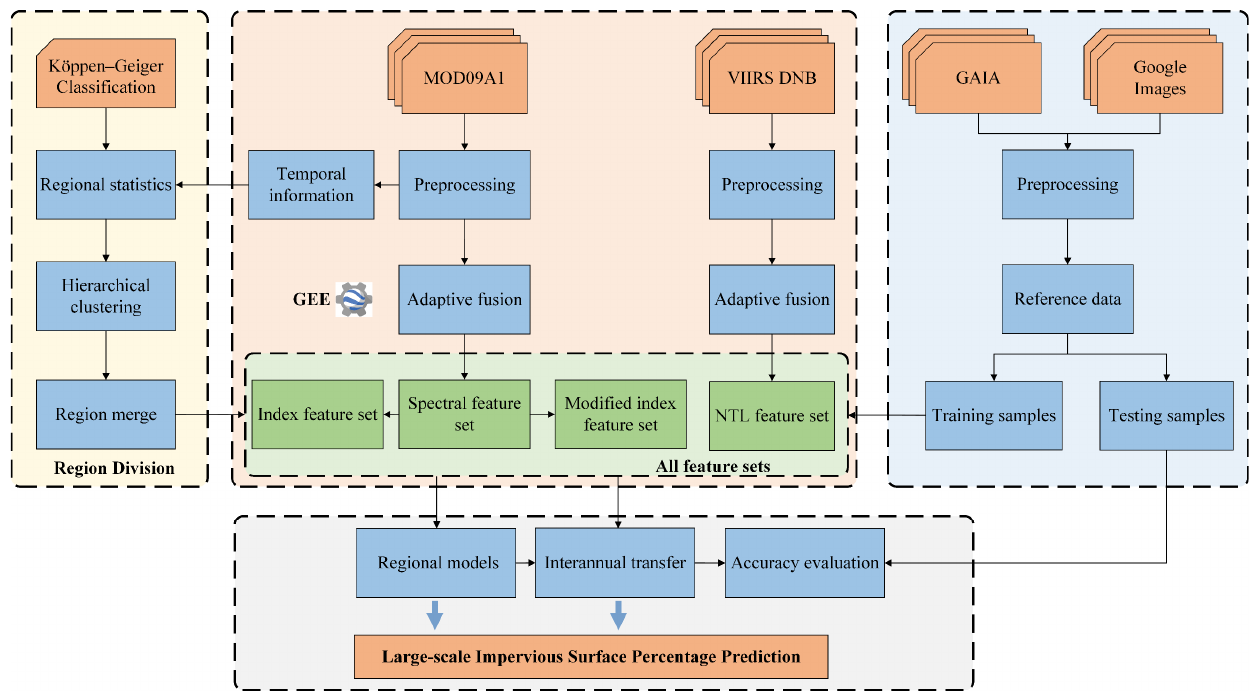
Figure 2. Flowchart for estimating the large-scale impervious surface percentage.